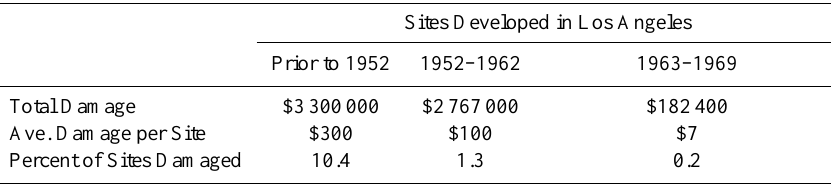
Table 2. Damage associated with the 1969 Storms in Los Angeles (modified from Fleming et al., 1979) in relation to more stringent planning requirements and increasing geologic involvement.